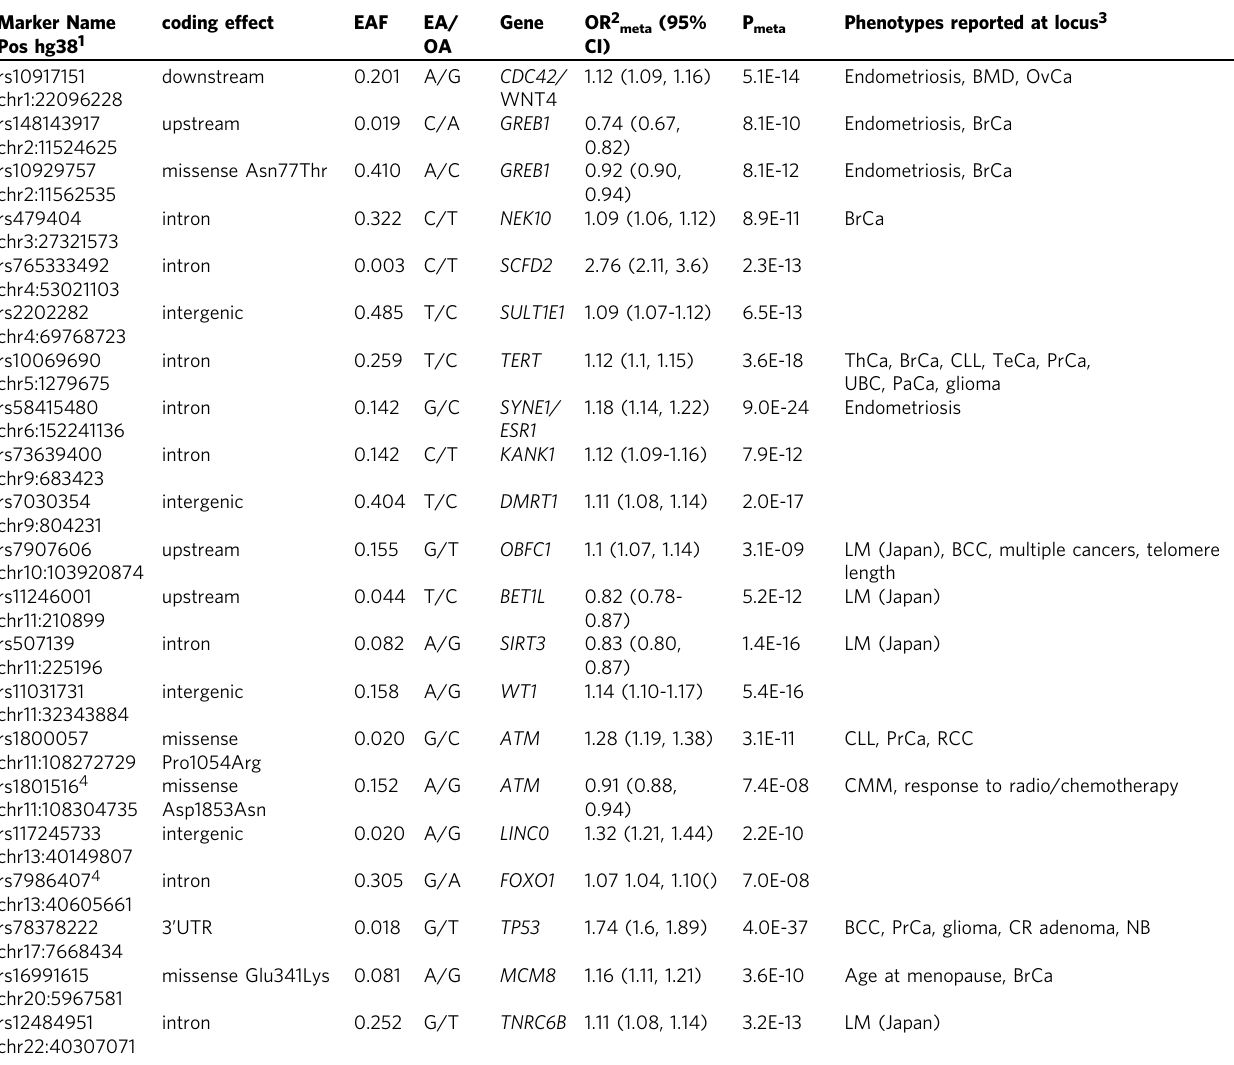
Table 1 Association results for lead variants at loci reaching genome-wide signi fi cance in meta-analysis of leiomyoma Marker Name Pos hg38